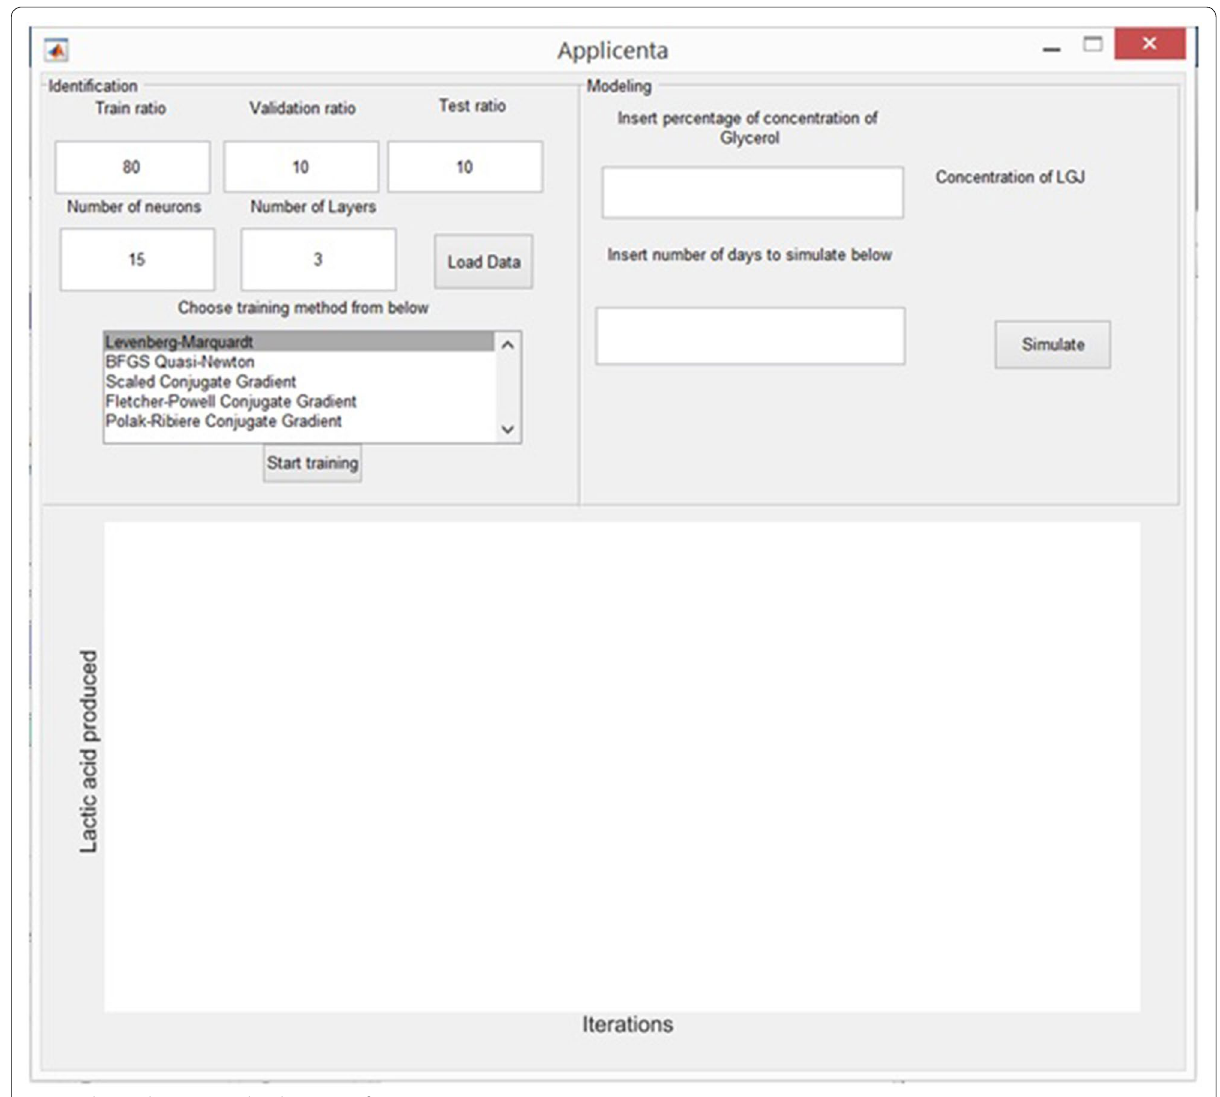
Fig. 1 The application graphical user